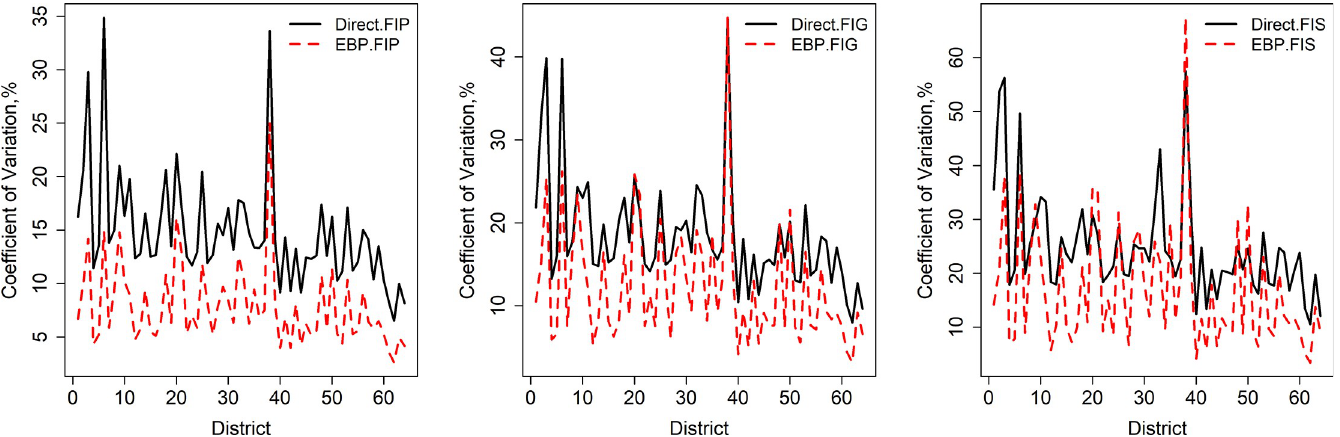
Fig 3. District-wise percentage coefficient of variation (CV, %) of FIP/HCR (left), FIG (centre), and FIS (right) food insecurity indicators generated by direct and EBP method. Districts are arranged in increasing order of sample size.